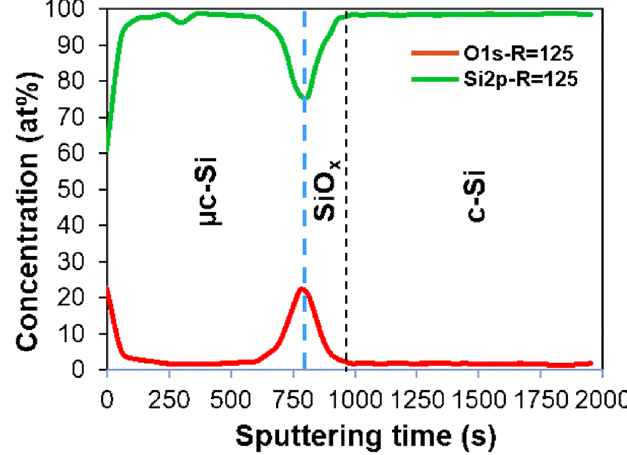
Fig. 3. Concentration pro fi le of an as-deposited stack of c-Si\PECVD SiO x \PECVD ( p + ) m c-Si:H (deposited with R =125) from